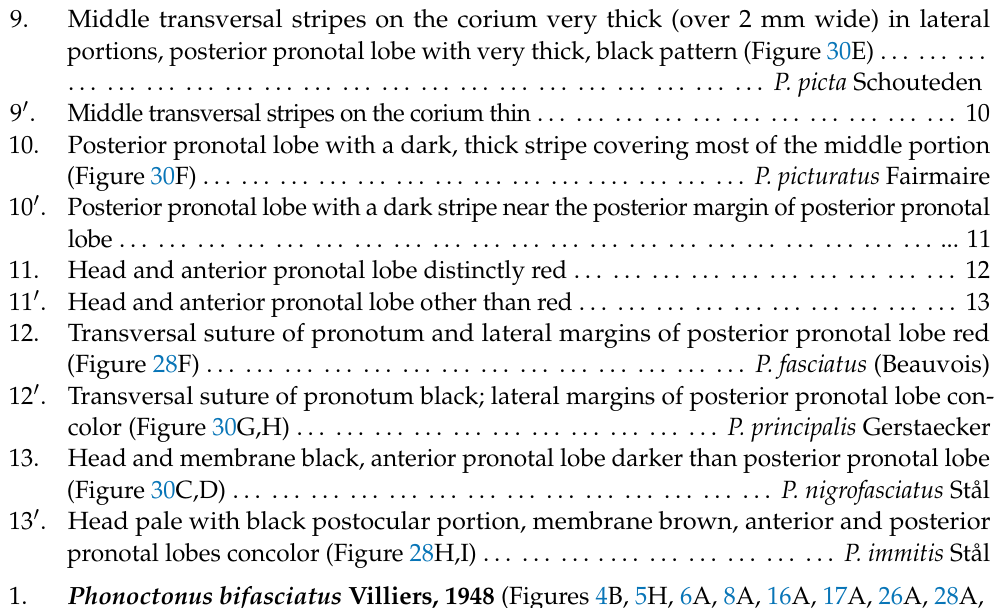
12. Transversal suture of pronotum and lateral margins of posterior pronotal lobe red (Figure 28F) . . . . . . . . . . . . . . . . . . . . . . . . . . . . . . . . . . . . . . . . . . P. fasciatus (Beauvois) 12 (cid:48) . Transversal suture of pronotum black; lateral margins of posterior pronotal lobe con- color (Figure 30G,H) . . . . . . . . . . . . . . . . . . . . . . . . . . . . . . . . . P. principalis Gerstaecker 13. Head and membrane black, anterior pronotal lobe darker than posterior pronotal lobe (Figure 30C,D) . . . . . . . . . . . . . . . . . . . . . . . . . . . . . . . . . . . . . . . . . . P. nigrofasciatus Stål 13 (cid:48) . Head pale with black postocular portion, membrane brown, anterior and posterior pronotal lobes concolor (Figure 28H,I) . . . . . . . . . . . . . . . . . . . . . . . . . . . . P. immitis Stål 1. Phonoctonus bifasciatus Villiers, 1948 (Figures 4B, 5H, 6A, 8A, 16A, 17A, 26A, 28A, 31A and 32) stat.